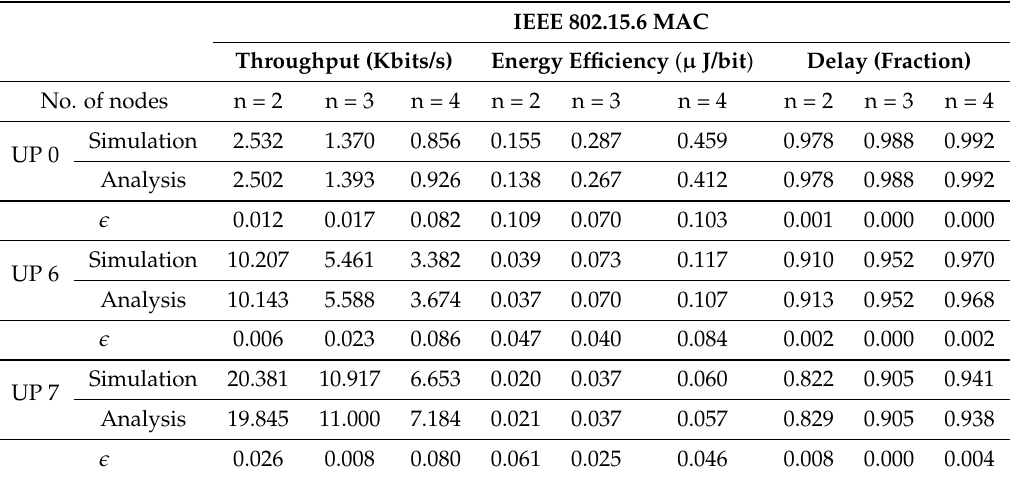
Table 3. Comparison of simulation and analytical results for IEEE